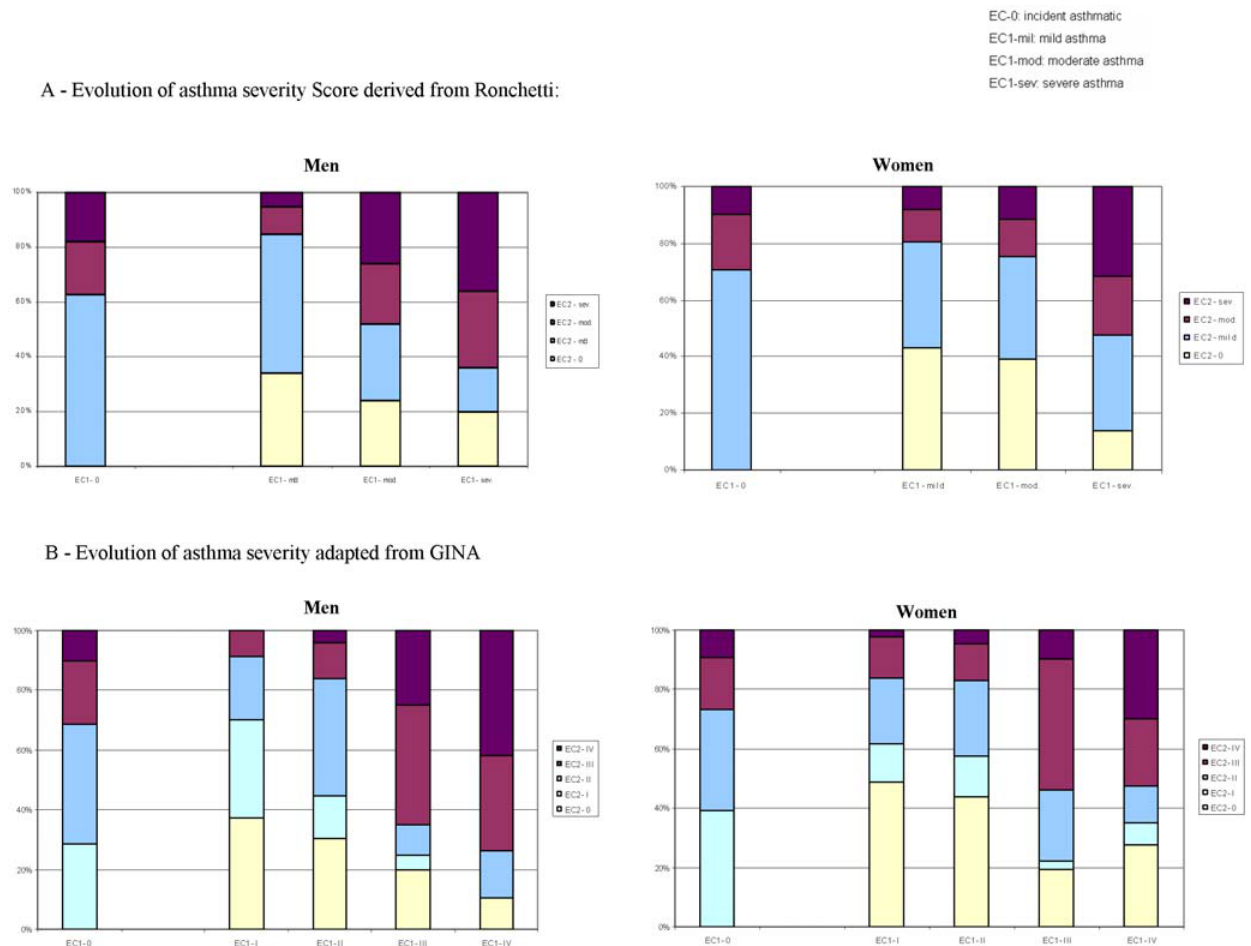
Figure 2. Distribution of asthma severity at EC2 in subjects without current asthma at EC1 (ECI-0) and in subjects with asthma, according to asthma severity at EC-1.